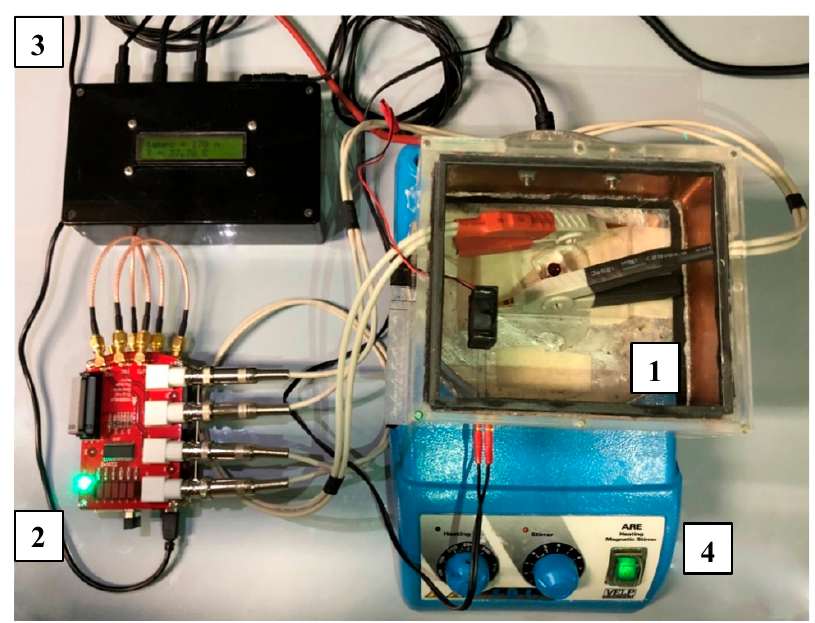
Figure 2. The MICELI aggregometer bench top setup with thermostatic chamber: 1) in-house manufactured thermostatic chamber; 2) impedance analyzer; 3) external unit controlling the thermostatic chamber; and 4) magnetic stirrer.